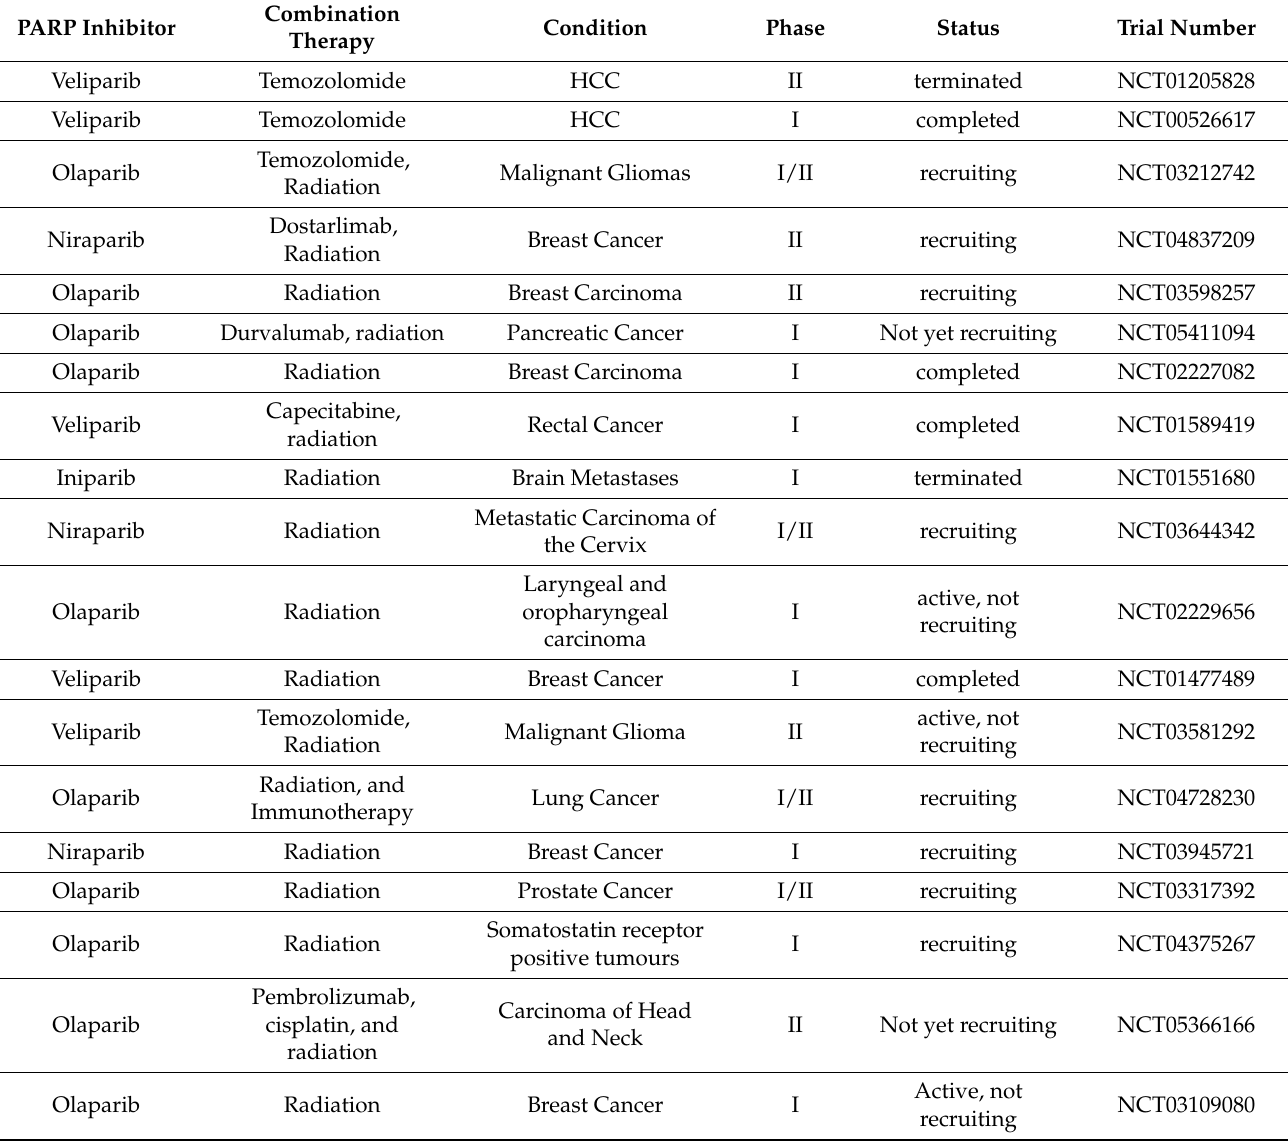
Table 1. Table of completed or ongoing clinical trials of PARP inhibitor combinations with radiother- apy in different cancers compared with clinical trials of PARP inhibitors in HCC. The high number of clinical trials of PARP inhibitors in combination with radiotherapy in other cancers highlights the interest in studying strategies that combine multiple therapies, such as PARP inhibitors and radiotherapy for the treatment of HCC (https://clinicaltrials.gov/ accessed on 29 July